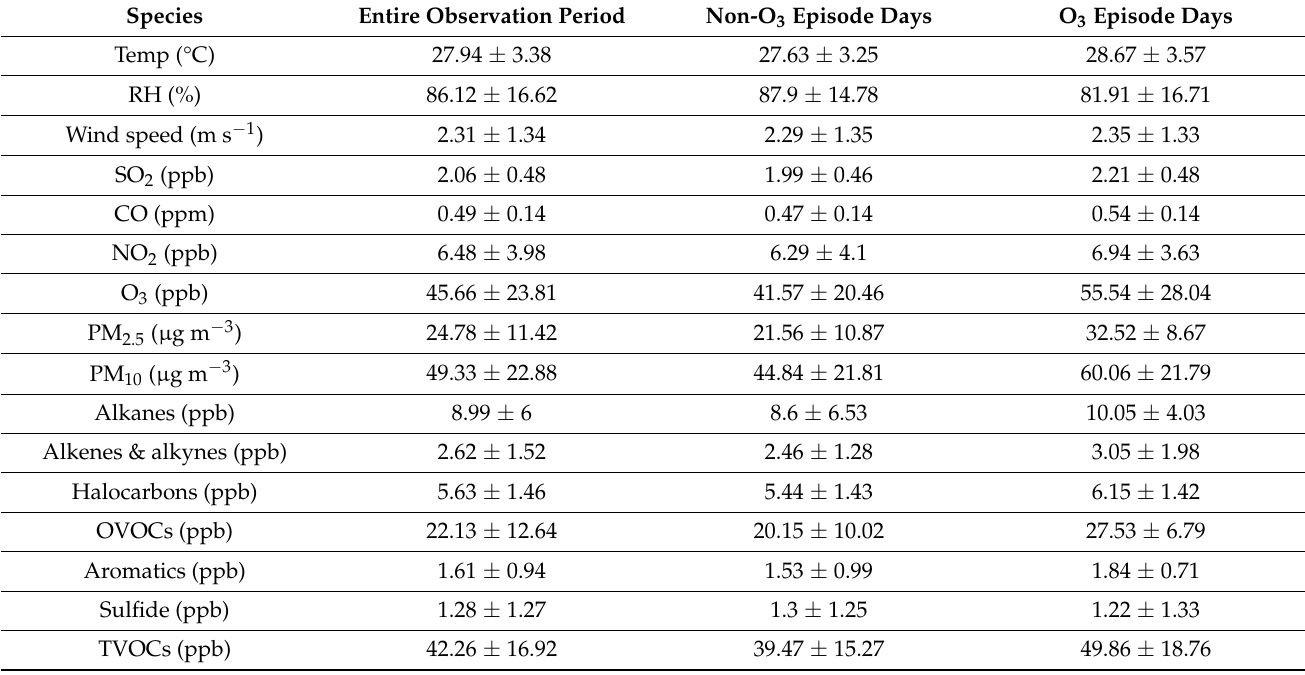
Table 2. Average values of air pollutants and meteorological parameters during the entire observation period, non-O 3 episode days, and O 3 episode